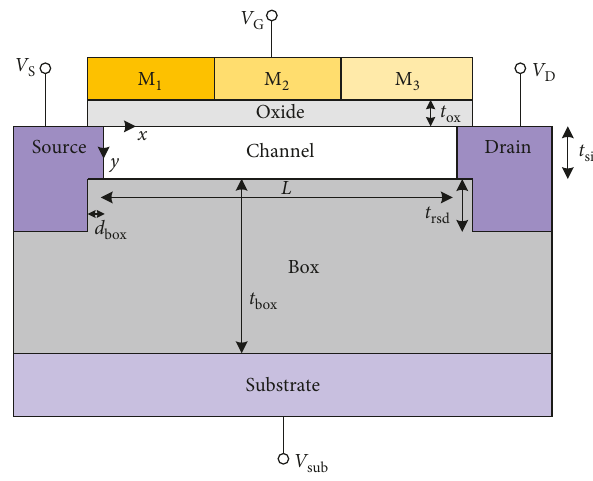
Figure 1: Cross-sectional view of TMG recessed-S/D UTB SOI